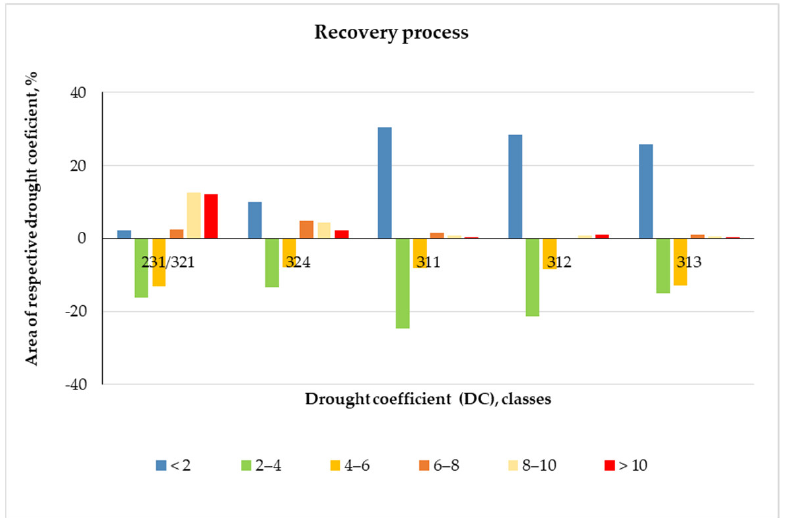
Figure 6. Recovery process of the individual land cover classes (LCCs) in the period between early August and mid-September shown as variation in Drought coefficient (DC) classes; 231/321—pastures and grasslands; 324—transitional woodlands and shrubs; 311—broadleaved forests; 312—coniferous forests; 313—mixed forests.